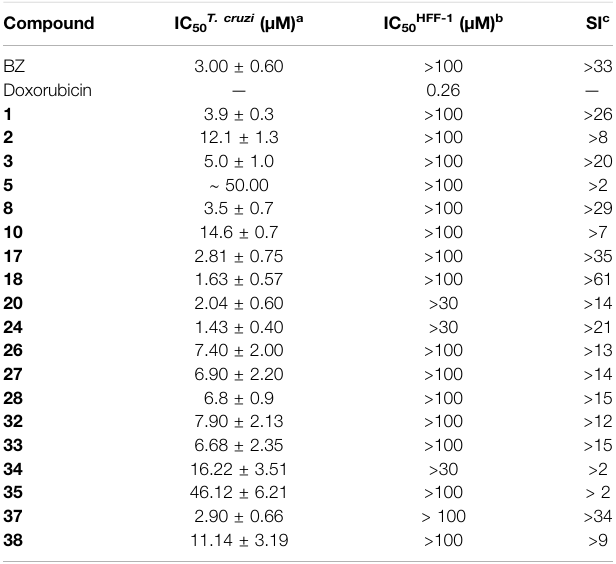
TABLE 4 | Biological evaluation of a subset of the benzimidazoles against T. cruzi and human HFF-1 fi broblasts.